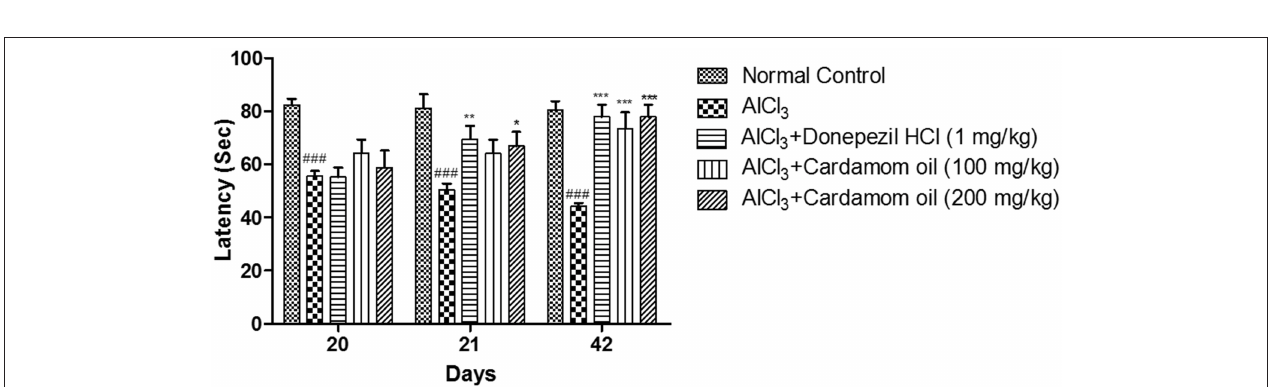
FIGURE 3 | Effect of Cardamom oil on transfer latency of rats using Elevated plus maze test in AlCl 3 -induced neurotoxicity. Data are expressed as mean ± SEM ( n = 6), ##p < 0.01, ### p < 0.001 when compared with normal control, * p < 0.05, ** p < 0.01, *** P < 0.001 when compared with disease control group. AlCl 3 , Aluminum chloride; SEM, Standard Error of Mean.